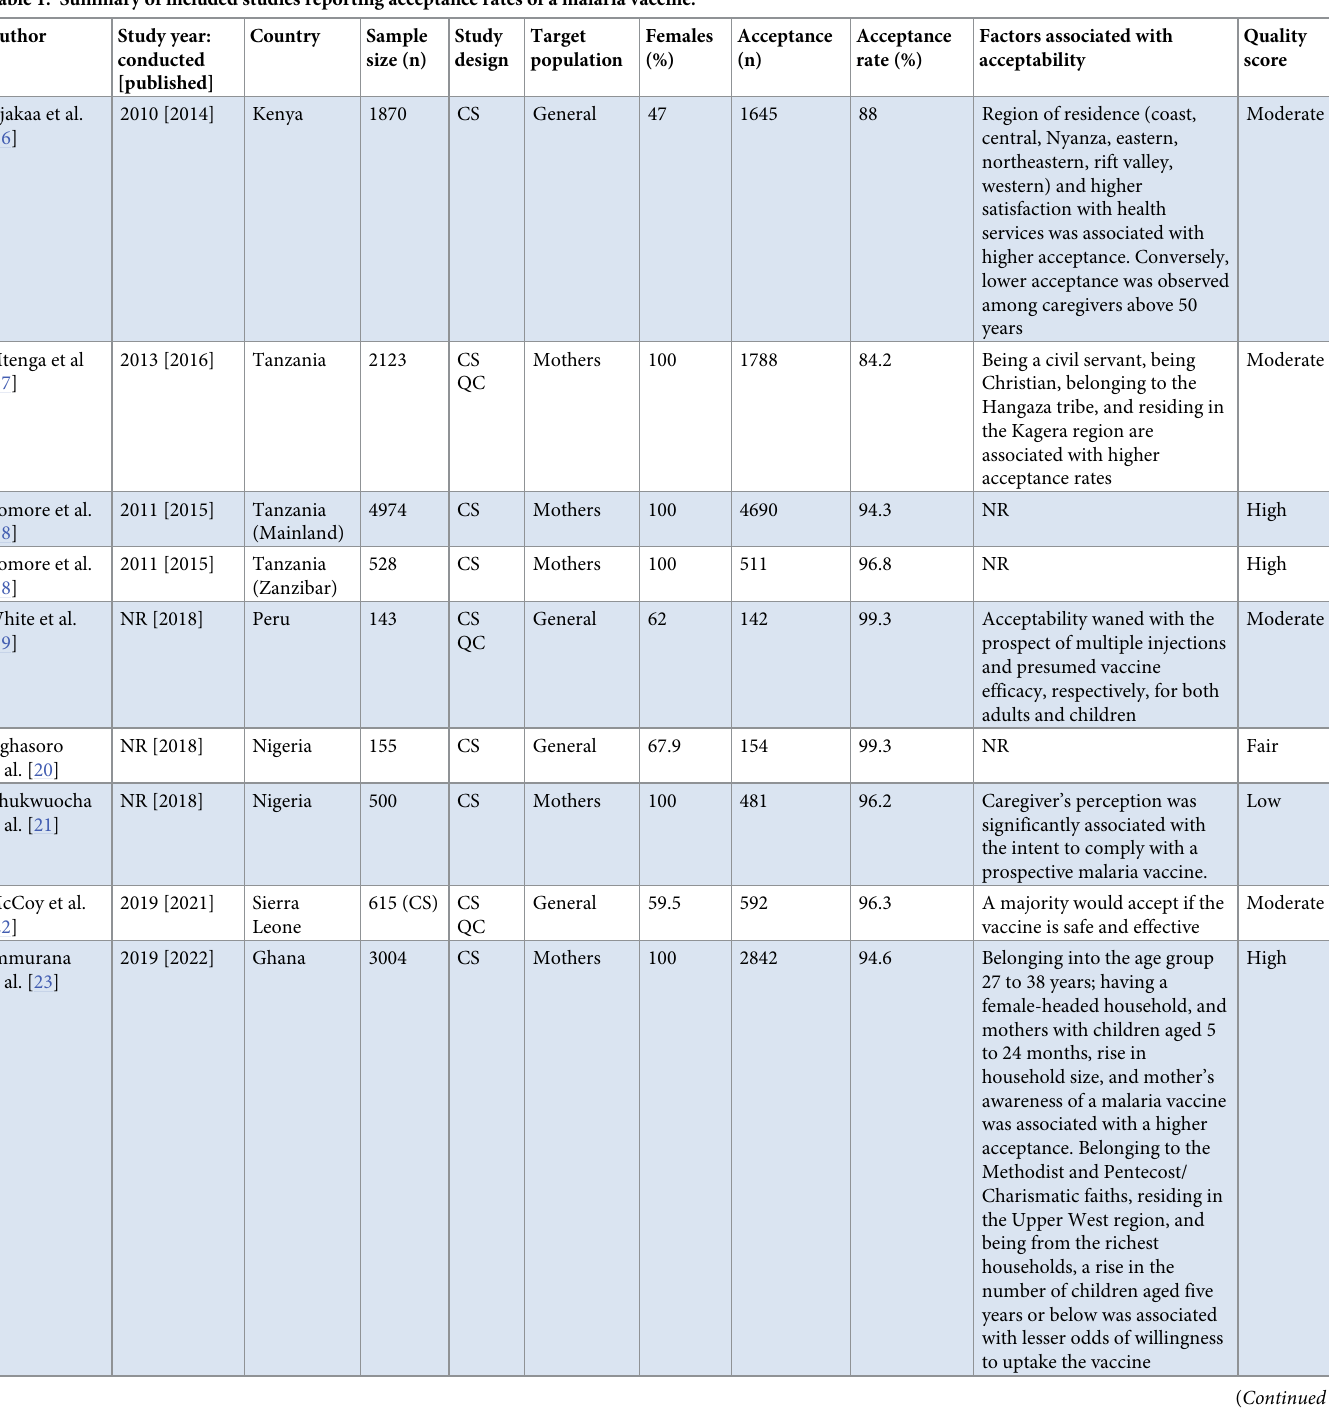
Table 1. Summary of included studies reporting acceptance rates of a malaria